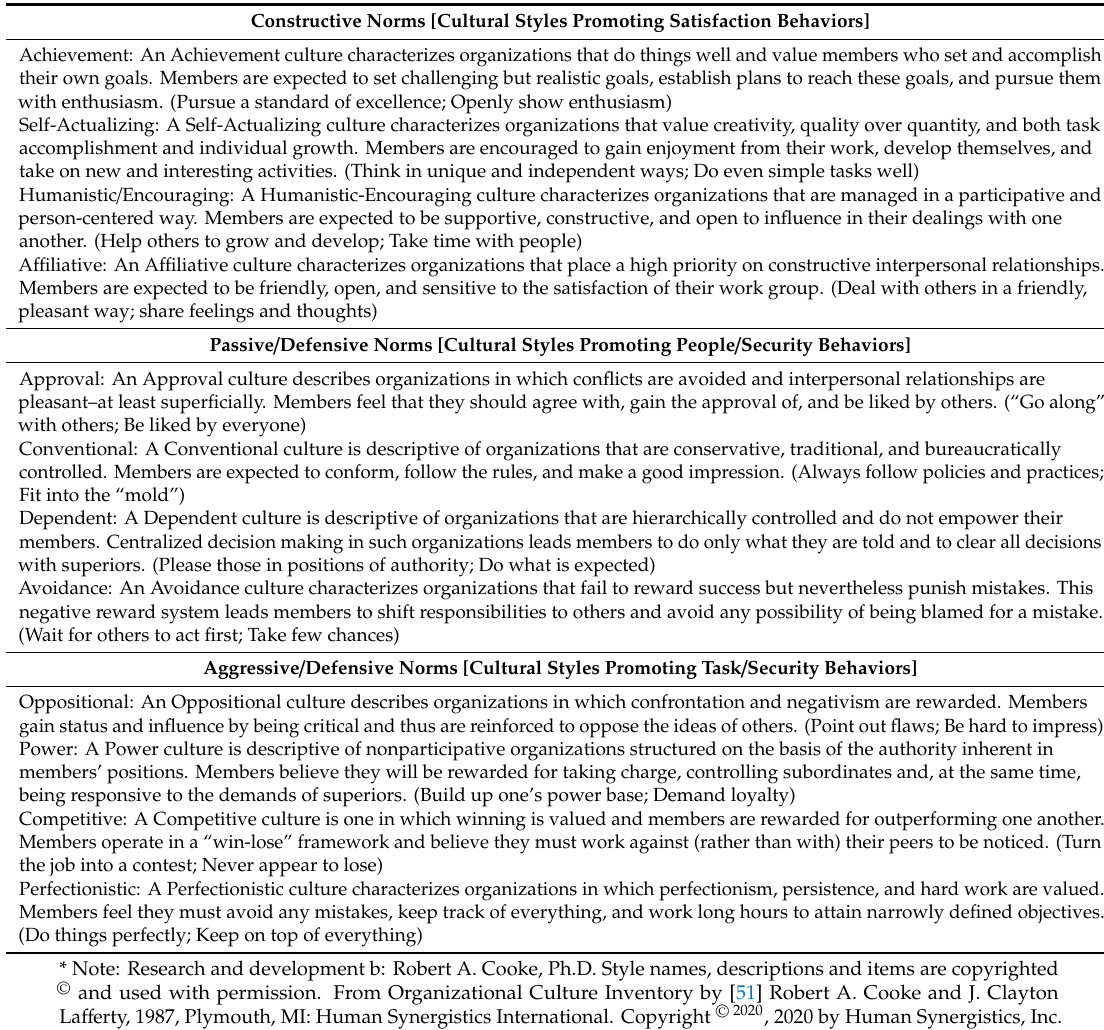
Table 2. Descriptions of the twelve styles measured by the Organizational Culture Inventory ® (OCI ® ) (and sample items)